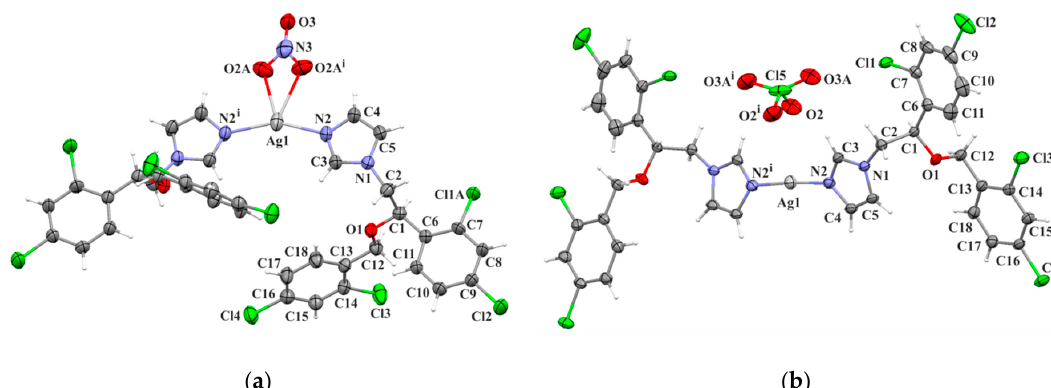
Figure 2. Molecular structures of Ag(I) complexes with miconazole and nitrate ( 1 ) ( a ) and perchlorate ( 2 ) ( b ) counter ions. The ellipsoids are drawn at the 30% ( 1 ) and 50% ( 2 ) probability level. The B-parts of the disordered atoms are omitted for clarity. Symmetry codes: for 1 (i) 1 − x , y , 1 − z 1 2